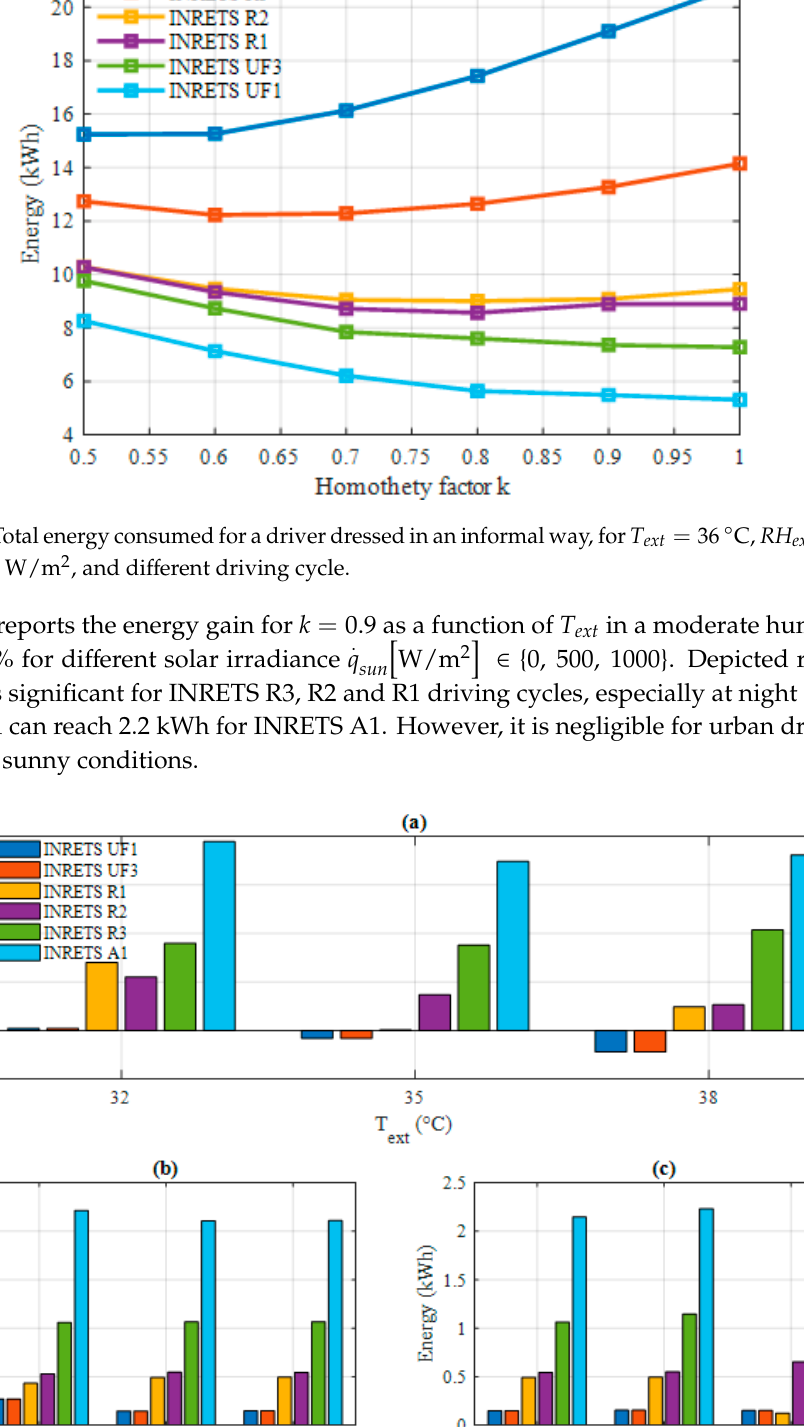
. = 1000 W/m 2 , ( b ) (cid:1869) (cid:4662) = 1000 W/m 2 , ( b ) . q q (cid:1871)(cid:1873)(cid:1866) sun